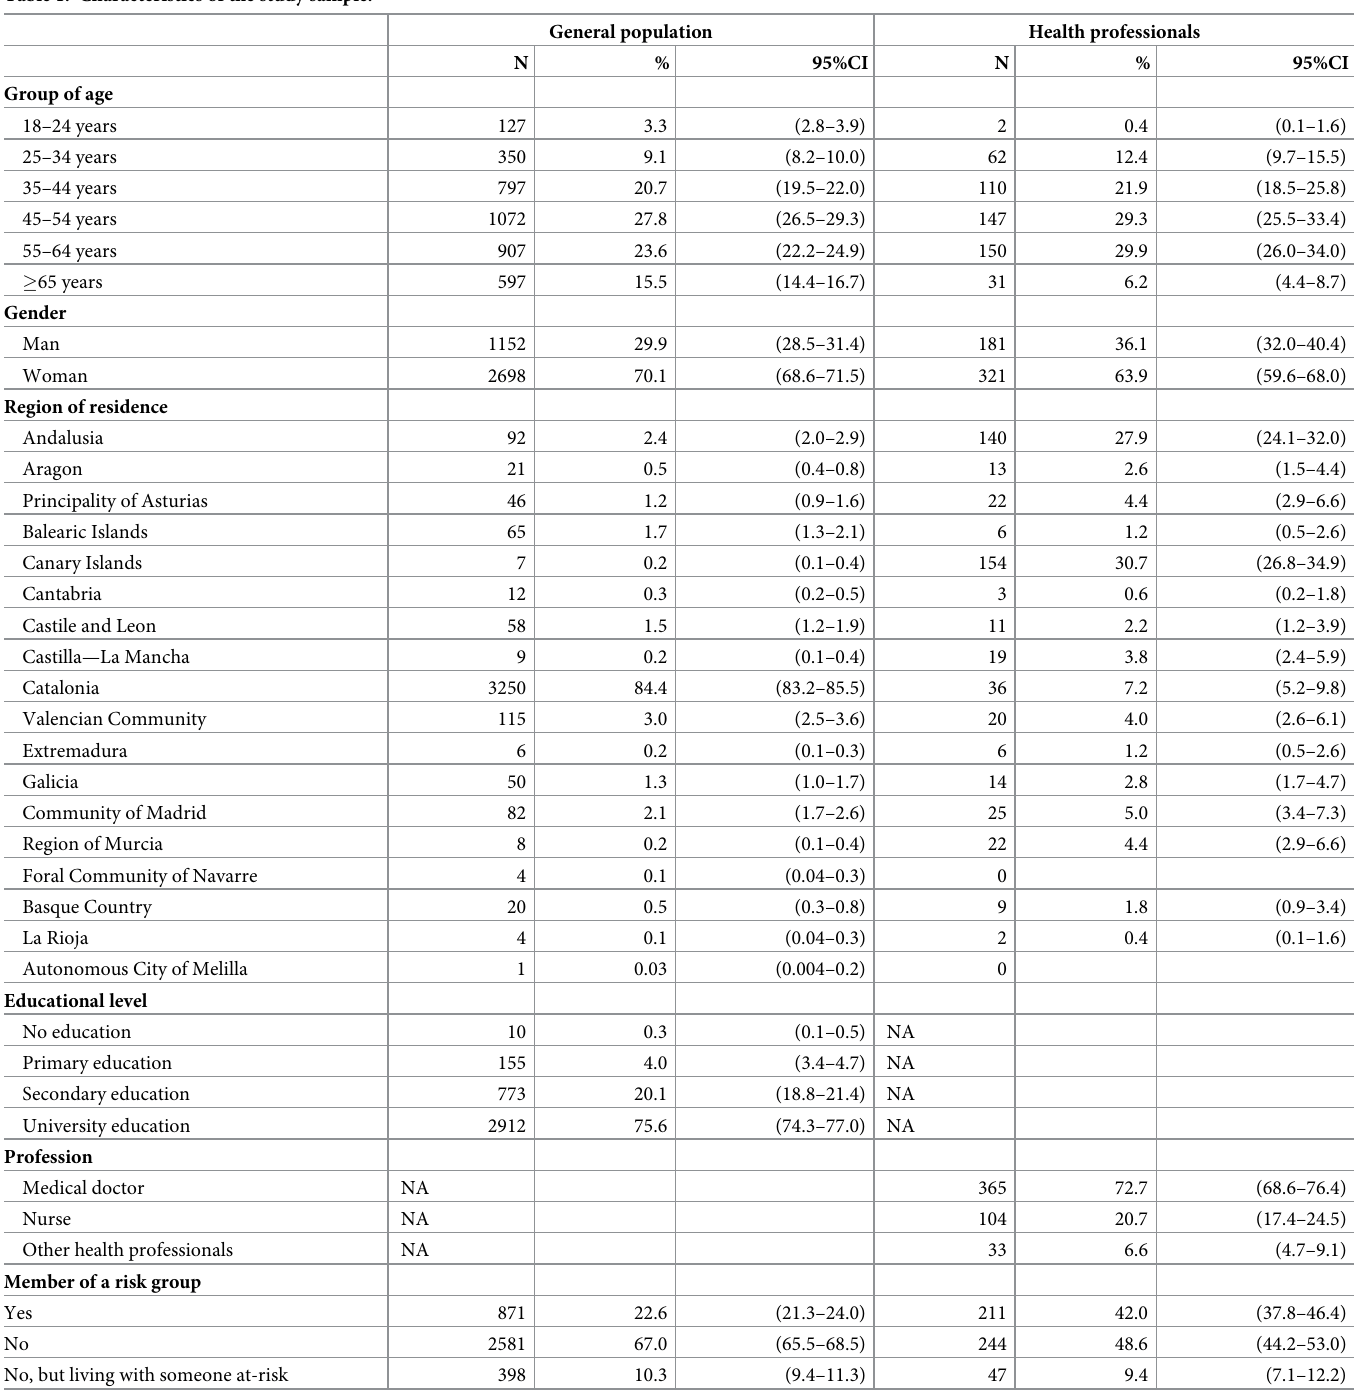
Table 1. Characteristics of the study